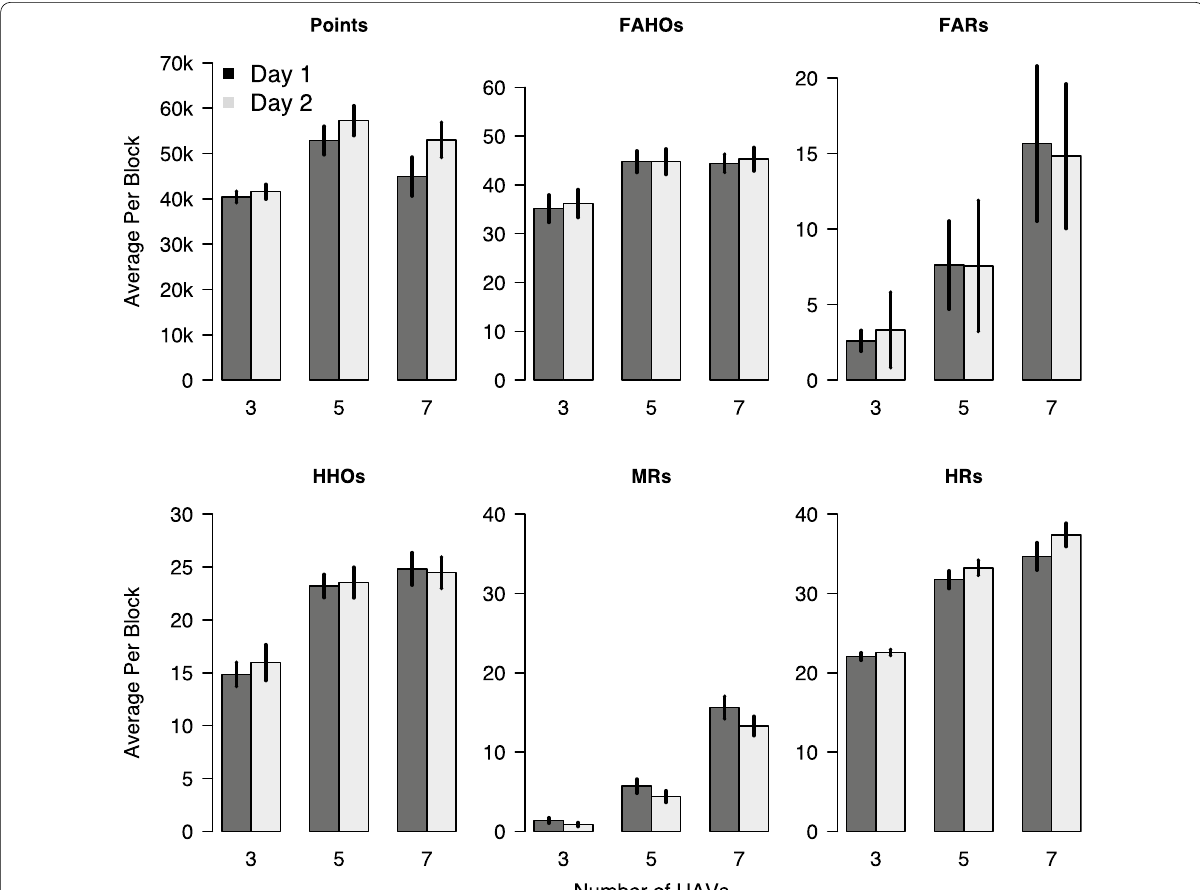
Fig. 2 Overview of points earned and frequency of different task events (see Table 1 for definitions) per block for both testing days and the three difficulty conditions. Error bars without caps show mean ± 1.96 SEM